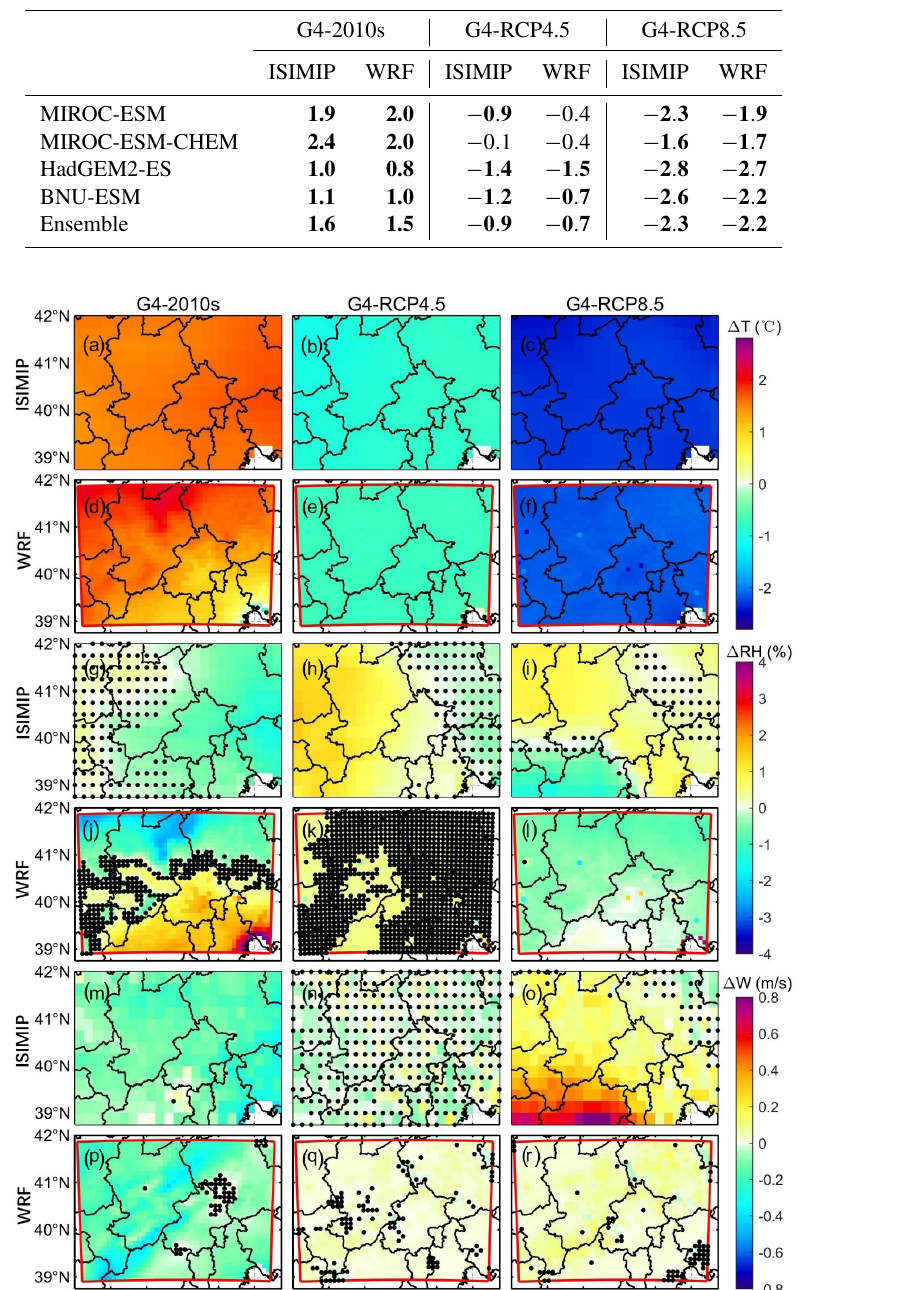
Figure 10. Spatial pattern of ensemble mean 2m temperature (a–f) , relative humidity (g–l) and 10m wind (m–r) scenario differences: G4-2010s (left column), G4-RCP4.5 (middle column) and G4-RCP8.5 (right column) based on ISIMIP-ESM and WRF-QDM-ESM results. 2010s means the results simulated during 2008–2017, and G4, RCP4.5 and RCP8.5 mean the results projected during 2060–2069. Stippling indicates grid points where differences are not significant at the 95% confidence level according to the Wilcoxon signed rank test. Figures S13–S18 show the results for each ISIMIP-ESM and WRF-QDM-ESM